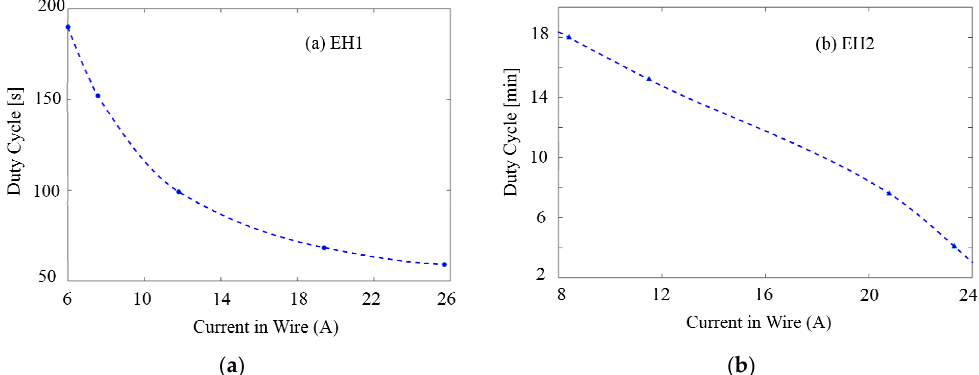
Figure 12 . Duty cycle of operation with regard to current intensity passing through the wire when the system is tested with ( a ) EH1 and ( b ) EH2. Higher current indicates a shorter duty cycle because of a weaker output power supplied by the EHs.